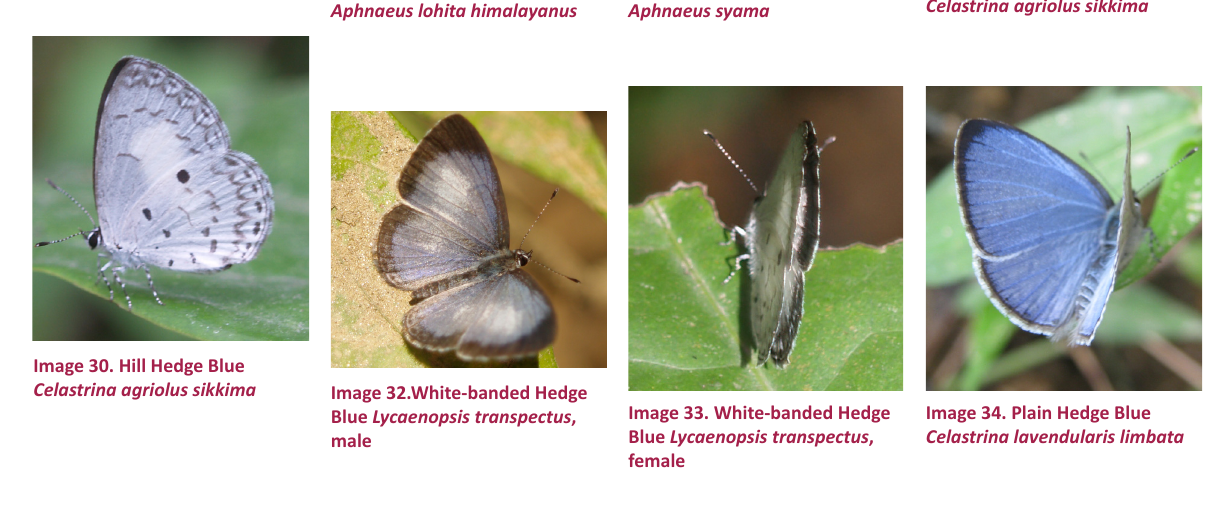
Image 29. Club Silverline, Aphnaeus syama